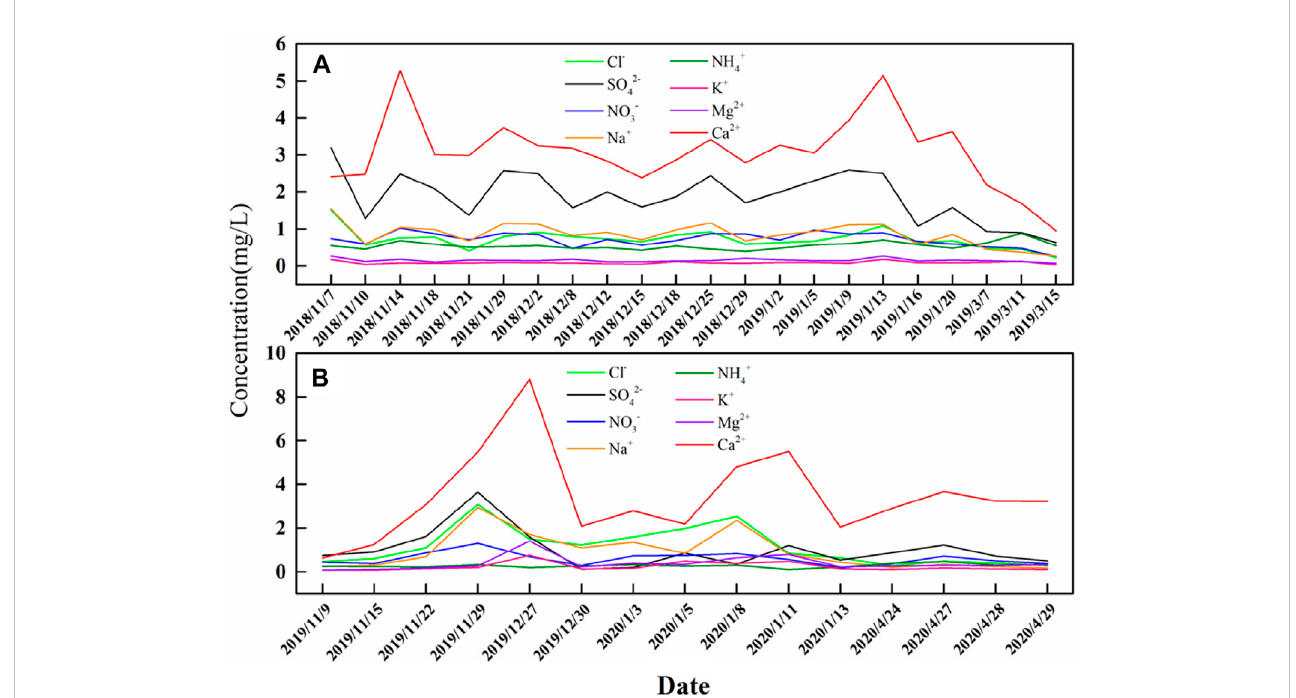
FIGURE 7 Temporal variation of several major inorganic ions in Heihe region, where (A) is in 2018/2019, and (B) is in 2019/2020.